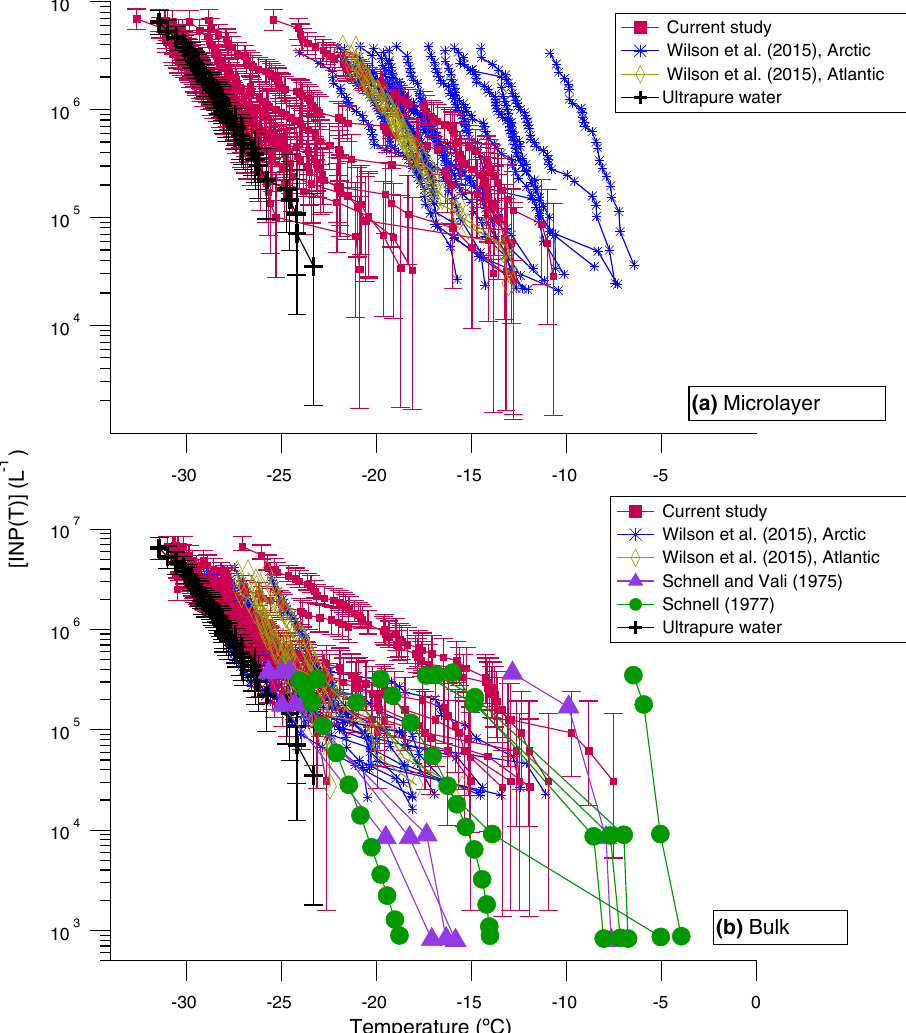
Figure 4. The concentrations of INPs, [INP (T) ], in the microlayer (a) and bulk seawater samples (b) . All data, including those from other studies, are corrected for freezing point depression. Upper and lower limits of [INP (T) ] (L − 1 ) associated with the current study describe the statistical uncertainty due to the limited number of nucleation events observed in the freezing experiments (Koop et al., 1997).